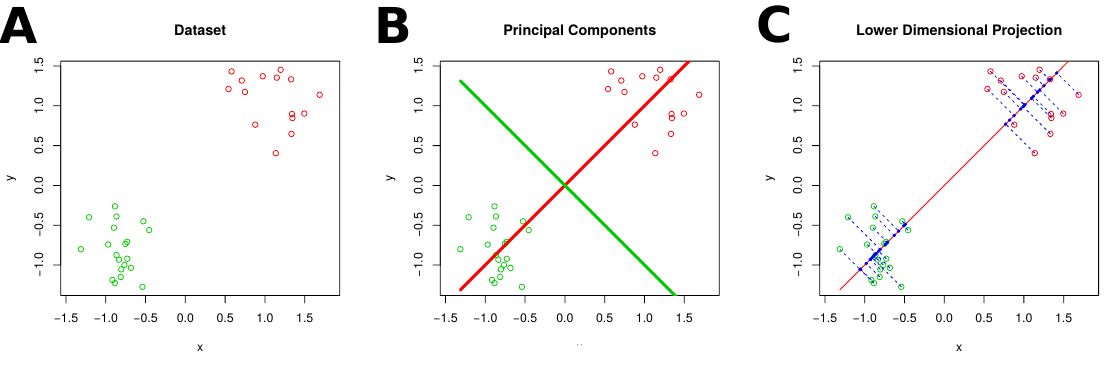
Figure 2: (A) clustering of a toy dataset of 35 objects with two distinct. The colors of the objects represent the clusters. (B) depicts the principal components of this dataset. The first principal component (red line) captures the most variance in the dataset. (C) displays the 1-dimensional projection of the dataset onto the first principal component (indicated in